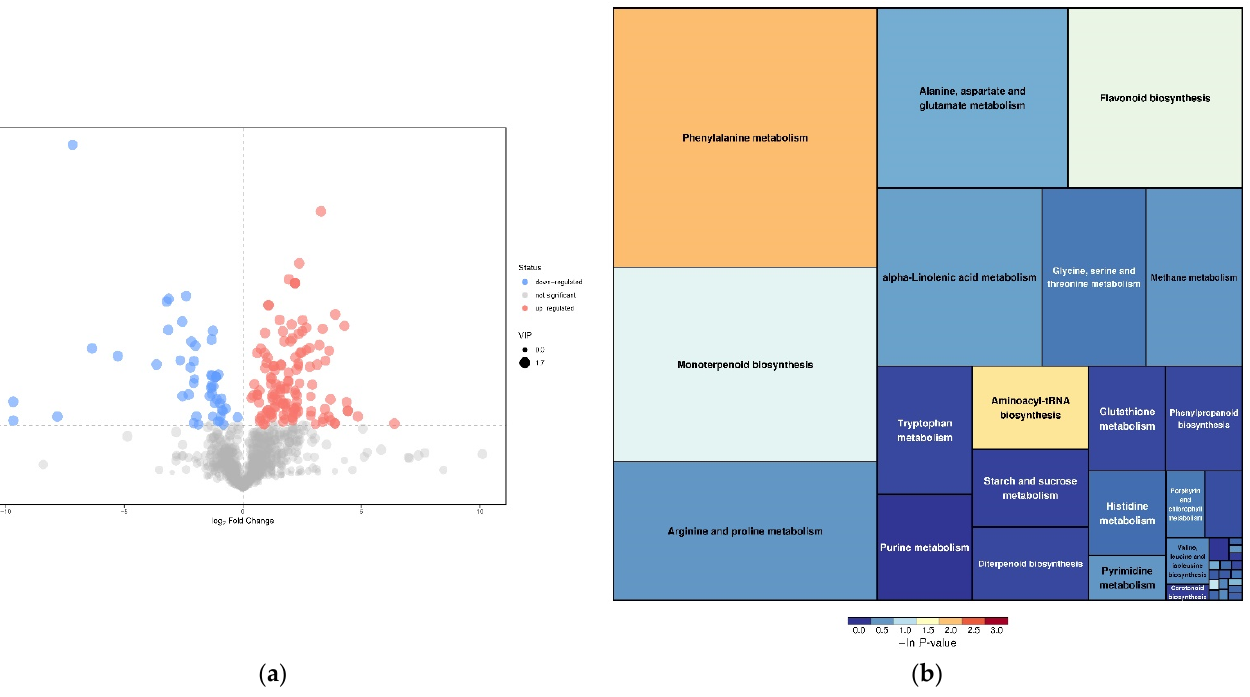
Figure 5. ( a ): Different accumulated metabolites volcano map. The abscissa is log2foldchange, and the integration is − log10 ( p -value). The red color dot indicates that the metabolite is up-regulated, the blue color dot indicates that the metabolite is reduced, and the ash represents a non-significant difference expression metabolite; ( b ): KEEG pathway analysis treemap plot. Each block represents an enriched metabolic pathway, each block size indicates that the impact of the pathway in topology analysis. The color of each block shows the enrichment of pathway.